Question: Describe this figure in one sentence.
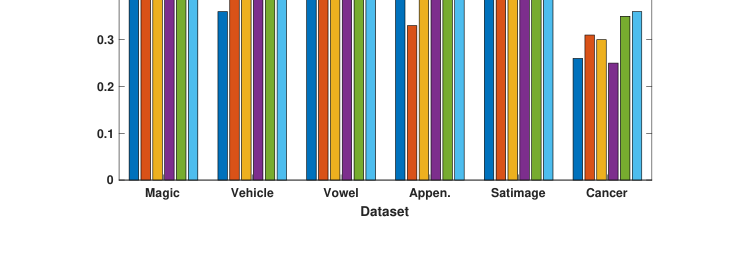
Answer: Matthew Correlation Coefficient according to the results of table 3.